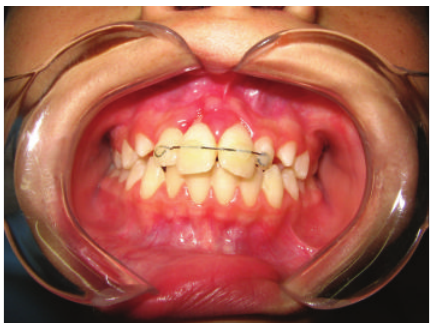
Figure 4: Postoperative clinical